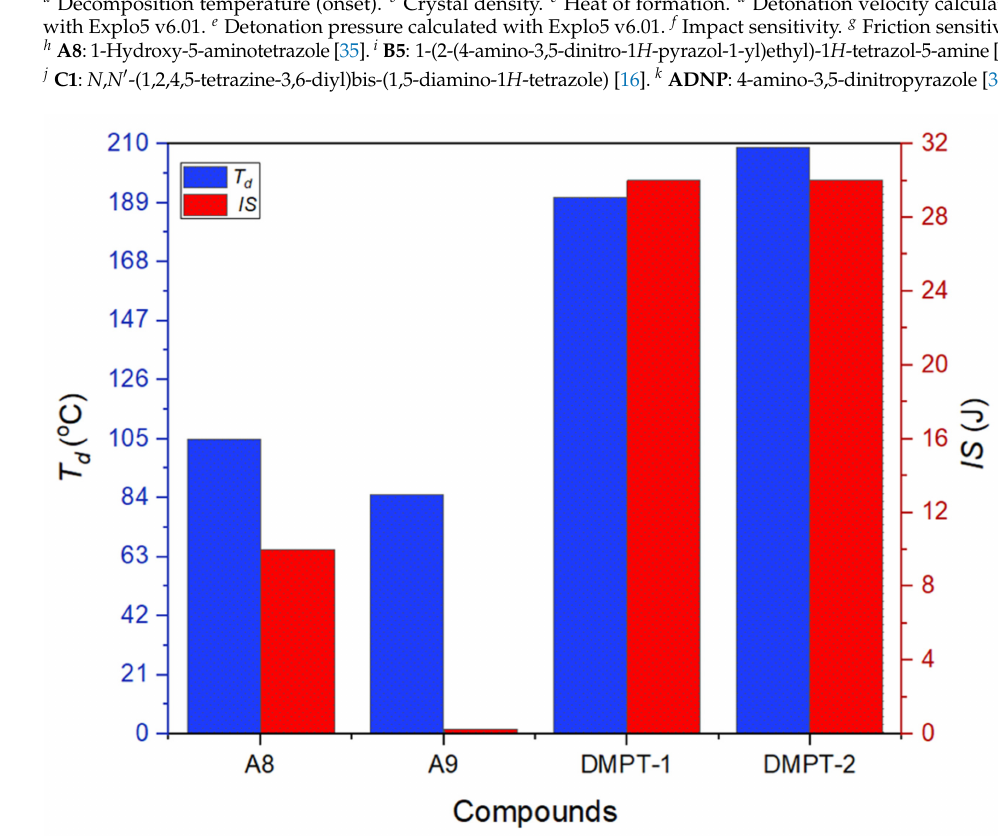
Figure 5. Thermostability and impact sensitivity of